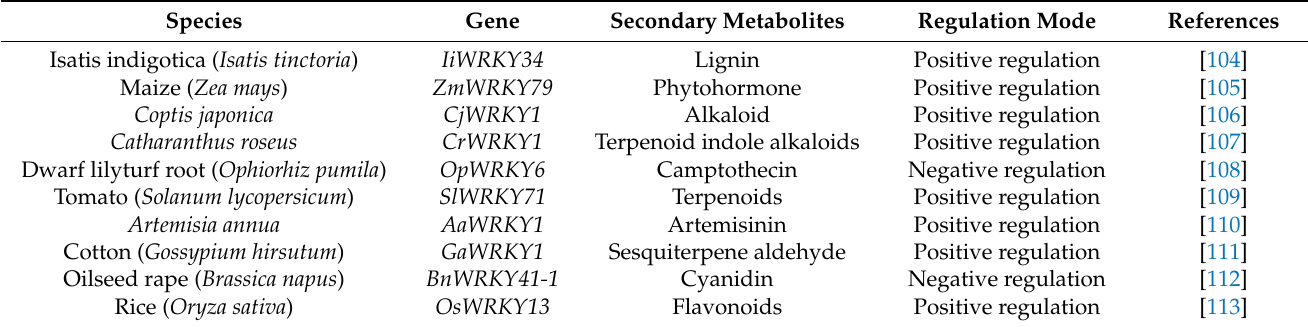
Table 4. Regulatory effects of WRKY transcription factors on plant secondary